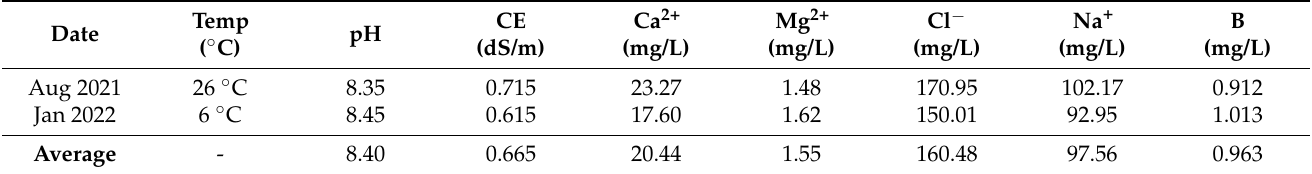
Table 1. Values of physical and chemical properties of the desalinated seawater supplied by the Escombreras desalination